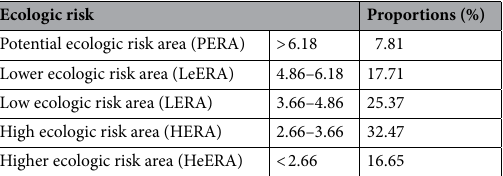
Table 8. Classification of ecological risks in the QTP and their proportions